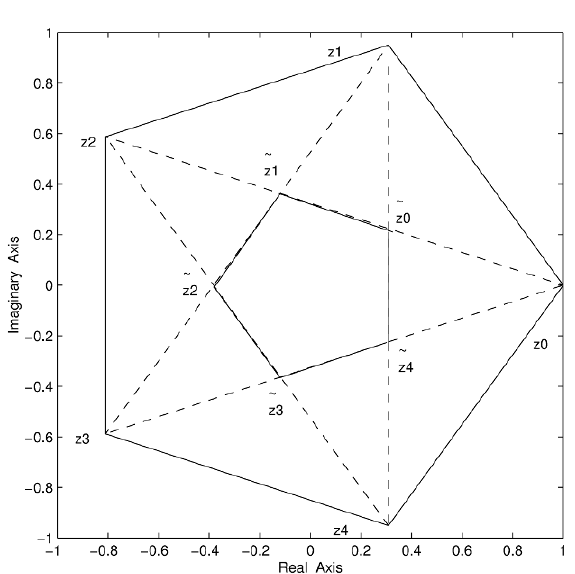
Figure 4. The outer and inner pentagons co {z 0 ,...,z 4 } and co { e z 0 ,..., e z 4 } are F ( P 5 ) and Λ 2 ( P 5 ) , respectively.